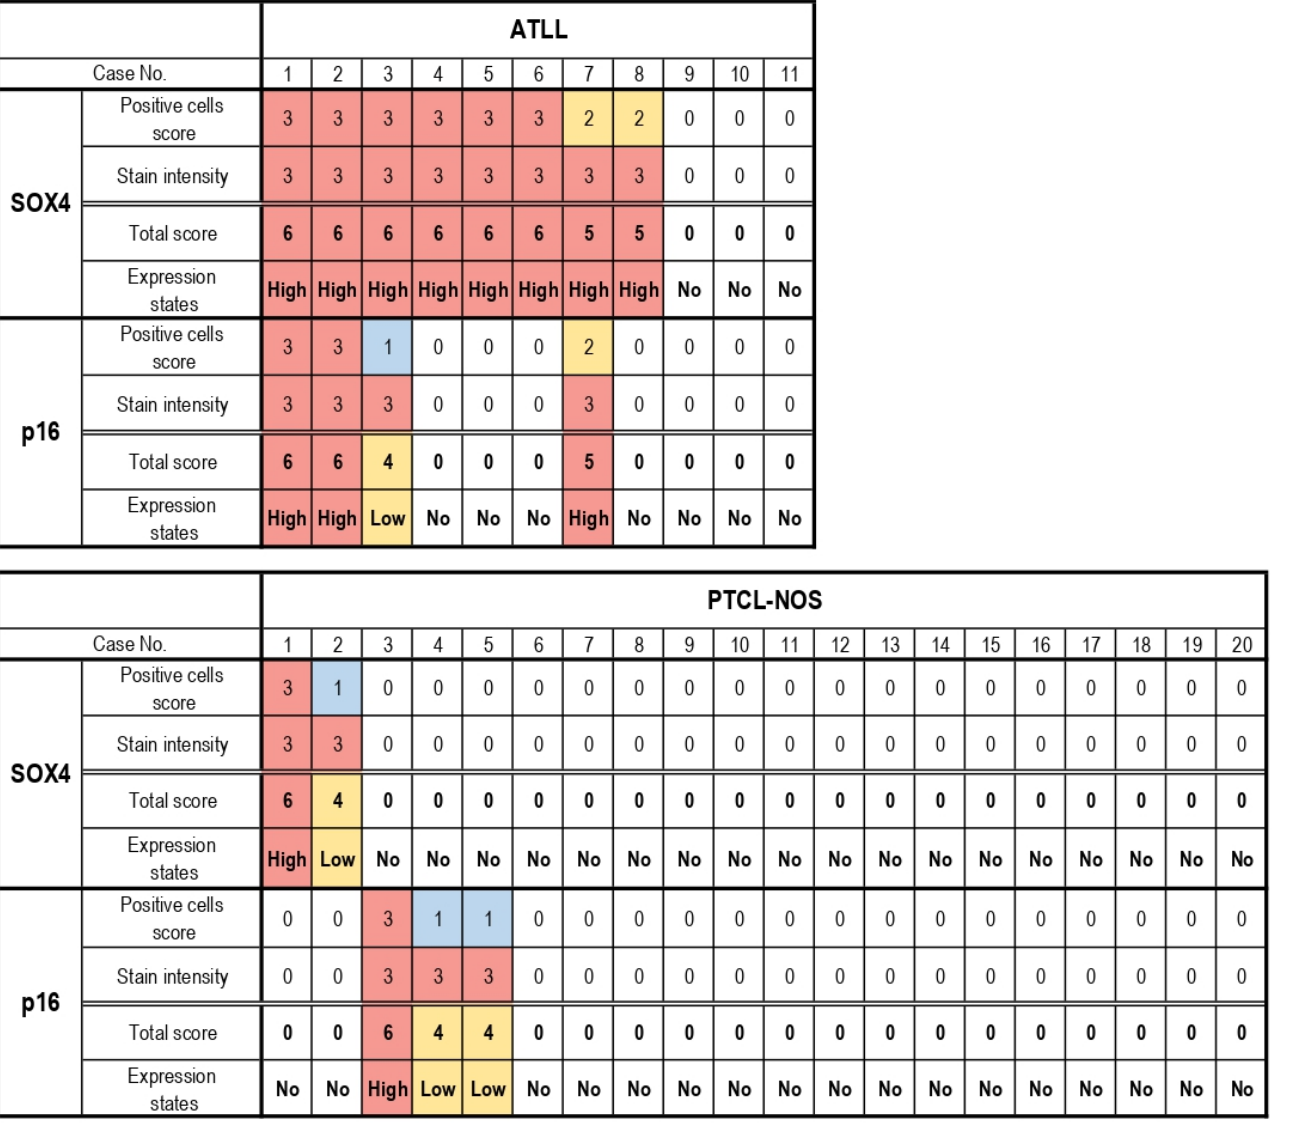
Figure 3. Heatmap representation of SOX4 and p16 immunostaining scores. A total of 8 cases with adult T-cell leukemia/lymphoma (ATLL) and 1 case with peripheral T-cell lymphoma, not otherwise specified (PTCL-NOS) exhibited high SOX4 expression. High p16 expression was noted in 3 ATLL cases and 1 PTCL-NOS case. The expression of SOX4 was significantly higher in ATLL than in PTCL-NOS ( p < 0.001).